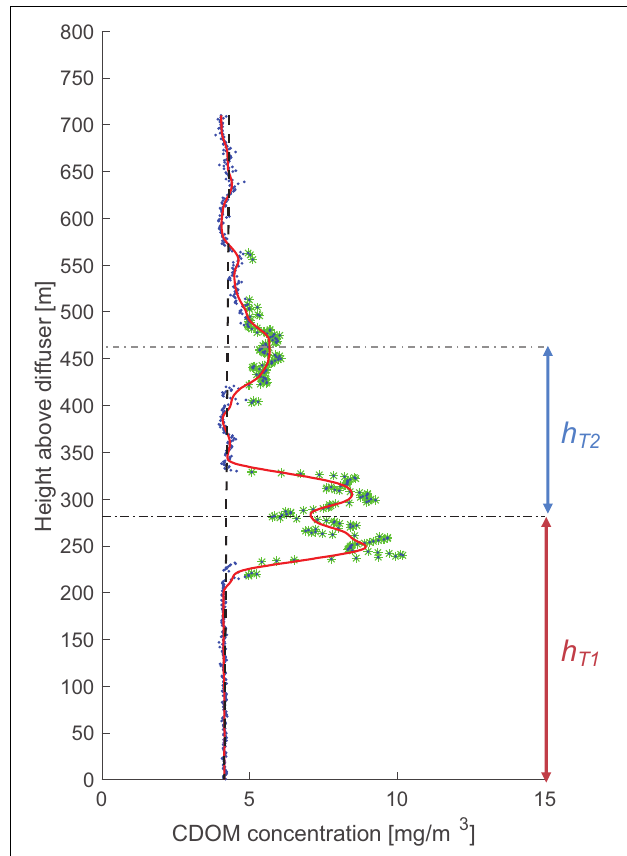
FIGURE 1 | Profile of fluorescence for the field measurement of R/V Walton Smith at station WS048-A on May 31st, 2010. Blue dots are raw measurements. The solid red line is the smoothed curve for the data based on the moving average, and the broken vertical black line is the computed background concentration. A comparison between the background concentration and smoothed curve for data exposes data with excessive fluorescence concentration, highlighted in green. The broken horizontal lines are the observed trap height for the primary and secondary intrusions. h T 1 and h T 2 denote primary and secondary intrusion heights,